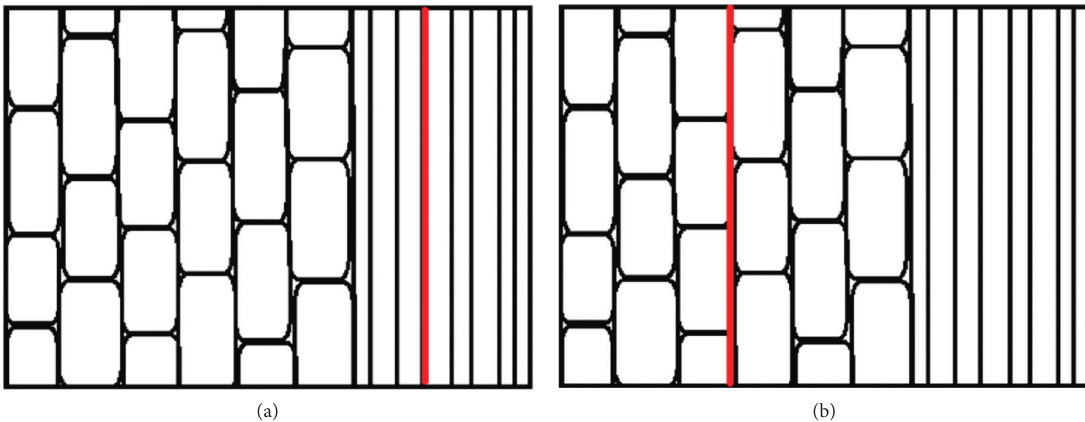
Figure 9: (a) Fibre debonding in compression test. (b) Plane fracture along parenchyma cell in compression test.